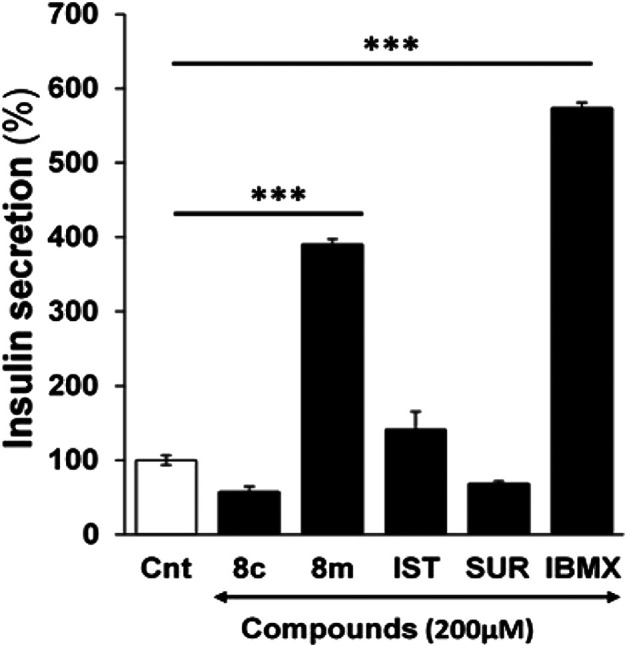
Effect of compound 8c, 8m, suramin (SUR), isatin (IST) and isobutyl methyl xanthine (IBMX) on glucose stimulated insulin secretion in mice pancreatic islets at 200 µM. Group of size-matched islets were incubated at 37°C for 1 h in KRB buffer with 16.7 mM glucose supplemented with or without test compounds. Values are mean ± S.E.M. from two to three independent experiments. Insulin secretion induced by 16.7 mM Glucose was considered 100%. ***p < 0.0001 vs. none. Cnt, insulin secretion induced by 16.7 mM glucose only.